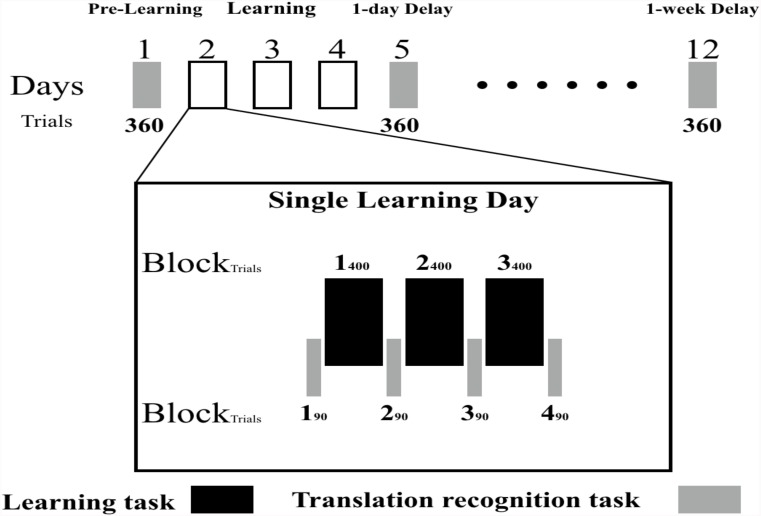
The learning and test procedure: the black rectangle in the picture represents the learning task; the gray rectangle in the picture represent the testing task; the black box represents the learning session. Participants took part in 1 pre-learning, 3 days of learning and 2 post-learning sessions. During the learning session, participants performed 4 blocks of translation recognition task (90 trials for each block) and 3 cycles of learning (400 trials for each cycle) in turn. During the presentation of word pairs, if the English word was a real word, participants were required to memorize the word pair; if the English word was a pseudoword, participants were required to press the “J” key to go to the next trial. A translation recognition task was used 1 day before learning session for the purpose of investigating the familiarity to those L2 words. The translation recognition task in post-learning session was used to test the learning effect of new meaning.